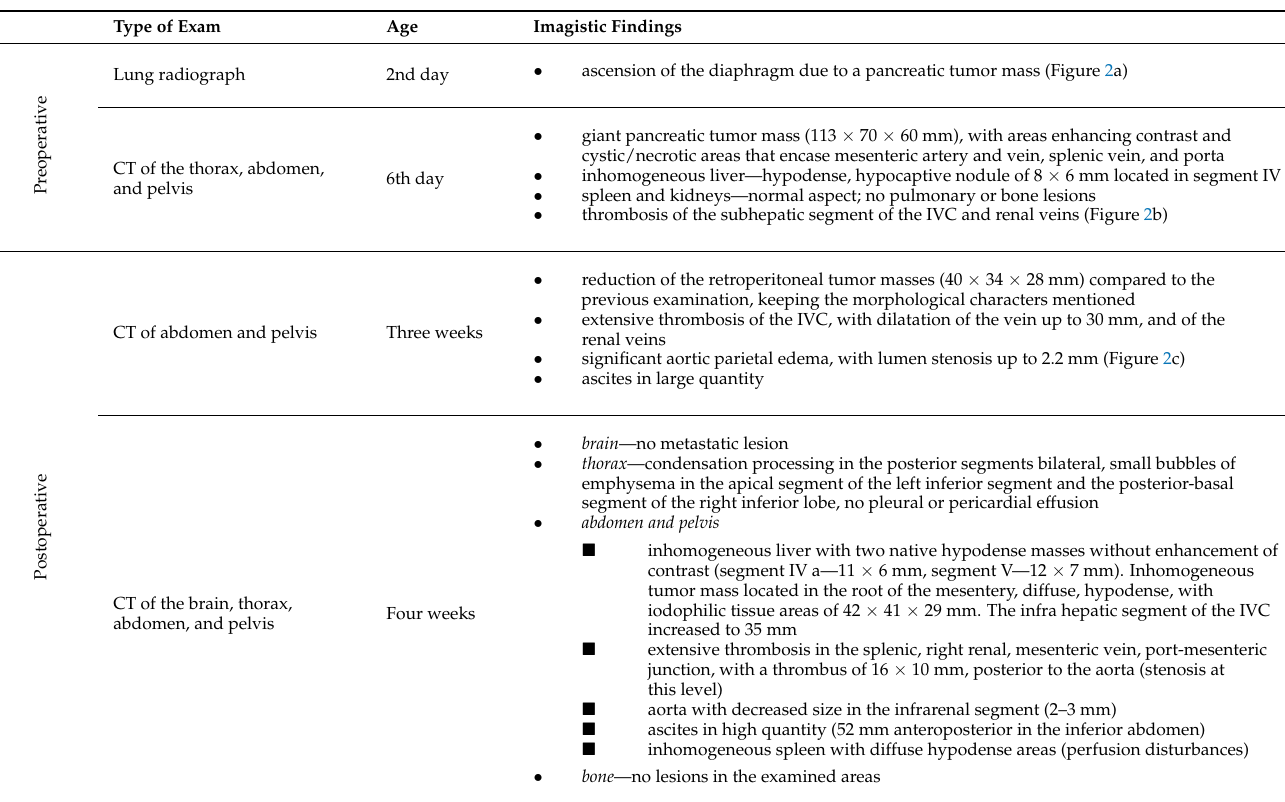
Table 2. Synopsis of postnatal imagistic findings.